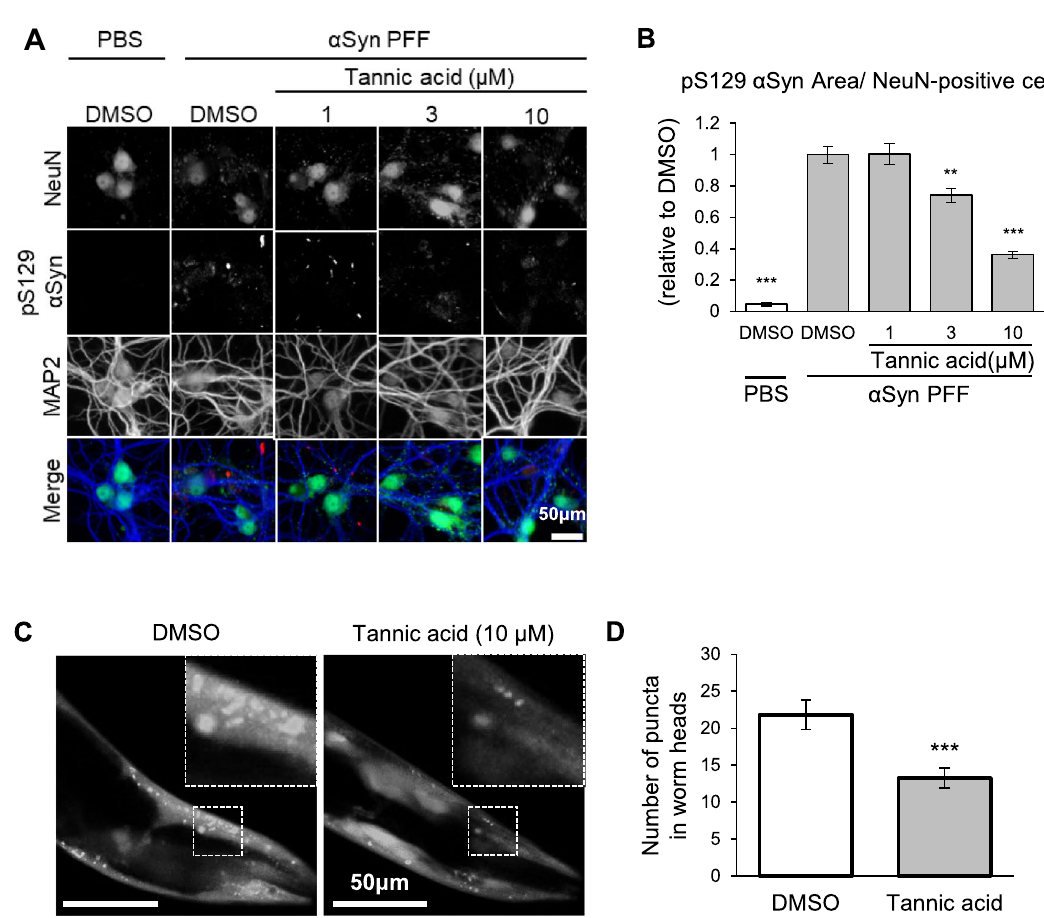
Figure 4. Tannic acid inhibits the formation of αSyn aggregates in mouse primary cultured neurons and PD model C. elegans . ( A ) Representative immunocytochemistry images of primary cultured neuronal cells treated with αSyn PFF and tannic acid. Primary neurons were treated with the indicated combinations at DIV 7, and were stained at DIV 14. ( B ) Quantification of pS129 αSyn in PFF- and tannic acid-treated neurons. Relative pS129 αSyn area per number of NeuN-positive neuronal cells was standardized by that of cells treated with αSyn PFF and DMSO. Data are shown as the mean ± SEM of three independent wells (n = 3; ** P < 0.01; *** P < 0.001; one-way ANOVA with the Dunnett compared with the αSyn PFF without tannic acid control) ( C ) Representative images of the heads of PD model C. elegans treated with DMSO or tannic acid. ( D ) Quantification of the number of obvious puncta in C. elegans treated with tannic acid or the DMSO control . Data are shown as the mean ± SEM of twenty-eight worms (n = 28; *** P < 0.001; Student t